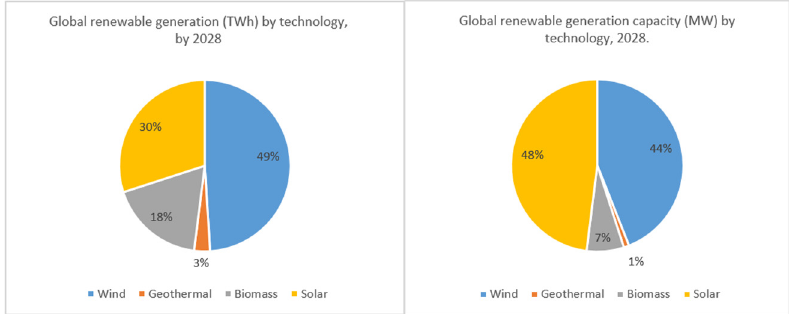
Figure 1. Global renewable generation and capacity by technology, by 2028 [2].